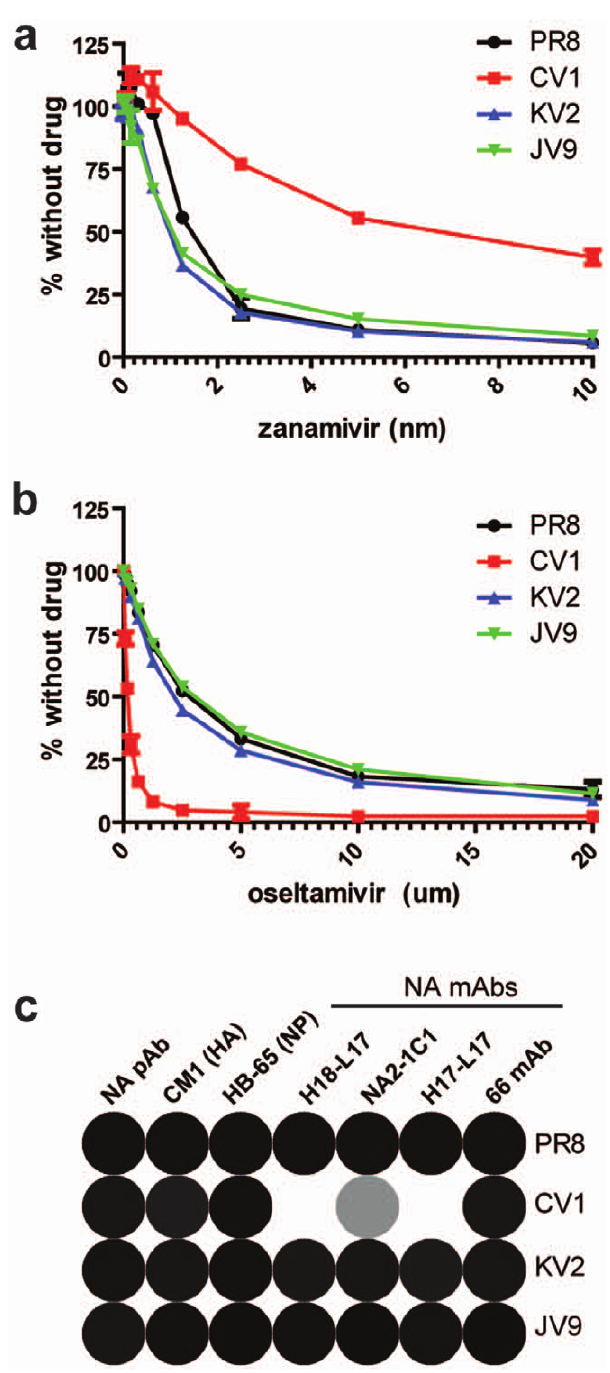
Figure 2. Compensatory mutations alter NA drug sensitivity and antigenicity. Viruses were pre-incubated with zanamivir (a) or oseltamivir (b) and NA activity was determined. (c) Relative binding affinities of 3 control Abs (NA polyclonal Ab, HA mAb, and NP mAb) and 4 anti-NA mAbs were determined using an ELISA assay. Ab titrations were performed and relative K d values were transformed into relative colors using the matrix2png software. Black indicates high binding affinity and white indicates low binding